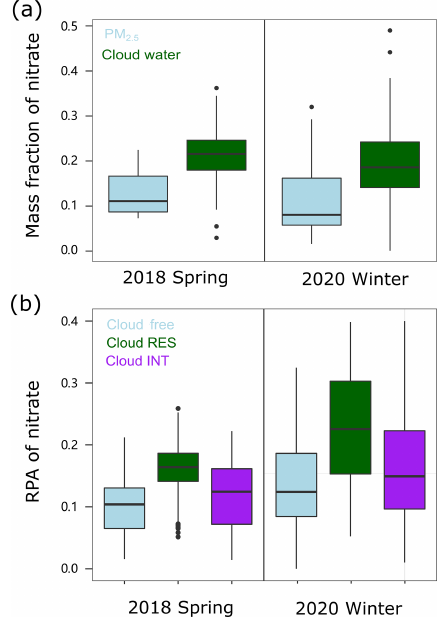
Figure 1. Box-and-whisker plots of (a) the mass fraction of nitrate in PM 2 . 5 and cloud water and (b) the RPA of nitrate separated for the cloud-free, cloud residual (RES), and cloud interstitial (INT) particles in spring 2018 and winter 2020, respectively. In a box-and- whisker plot, the lower, median, and upper line of the box denotes the 25th, 50th, and 75th percentiles, respectively. The lower and upper edges of the whisker denote the 10th and 90th percentiles,